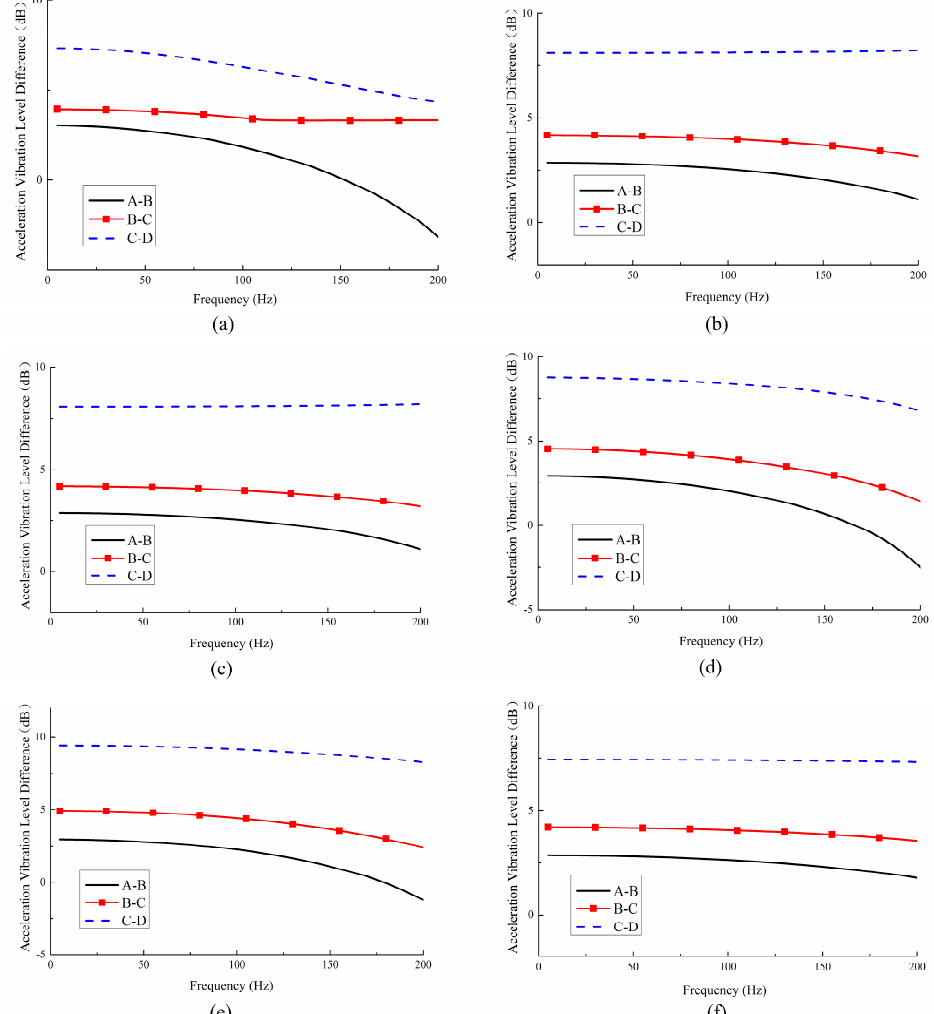
Figure 12. The vibration level difference (VLD) between measuring points A–B, B–C, and C–D corresponding to metamaterials with various PR values: ( a ) 𝜈 = −0.3 ; ( b ) 𝜈 = −0.6 ; ( c ) 𝜈 = −1.0 ; ( d ) 𝜈 = +0.3 ; ( e ) 𝜈 = +0.6 ; ( f ) 𝜈 = +1.0 .